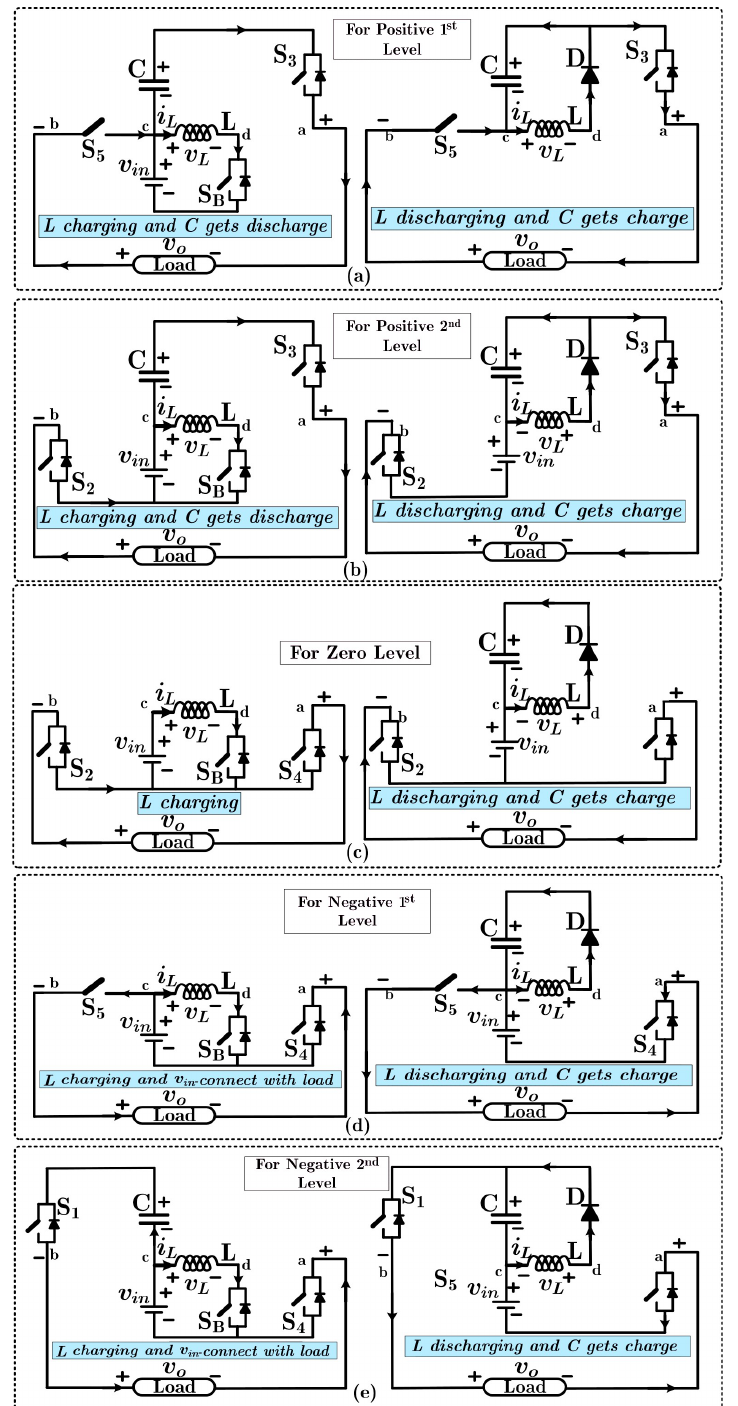
Figure 2. Modes of operation of proposed 5L-SB inverter topology with inductor charging and discharging for ( a ) +Level − 1, ( b ) +Level − 2, ( c ) Zero level, ( d ) − Level − 1, ( e ) − Level − 2. ( v L -inductor voltage, i L -inductor current, L—inductor, D—diode, C—capacitor, v in —input voltage, v o —output voltage, S 1 -S 5 , S B